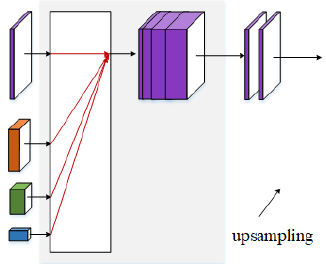
Figure 6. The output